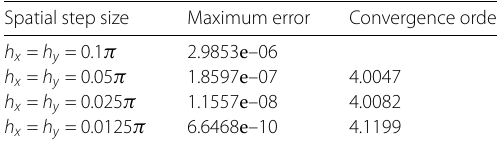
Table 11 The convergence order for R-ADI-CFDS4 at τ = 0.0001